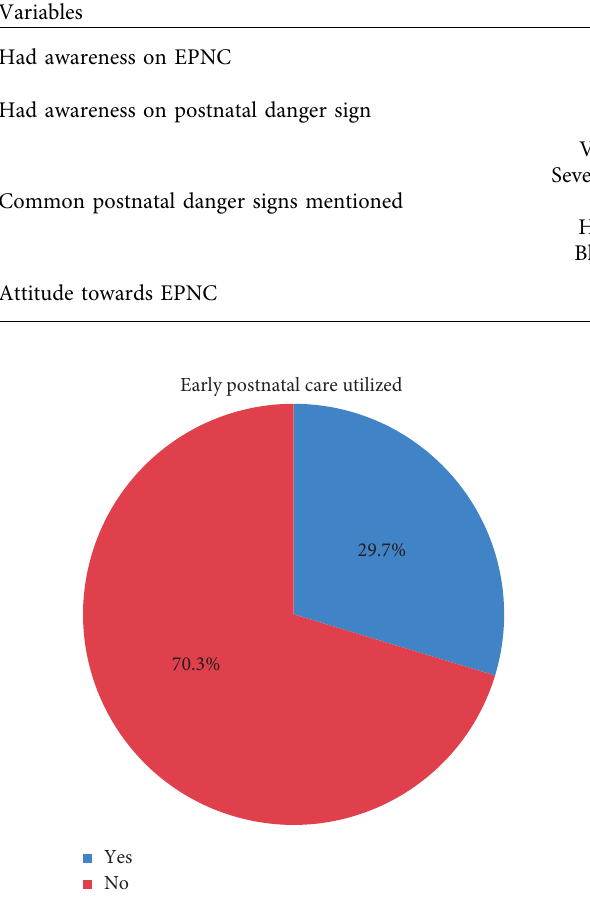
Figure 1: Magnitude of early postnatal-care services utilized by the respondents in Hawassa Zuria District, Sidama Regional State, Ethiopia, 2020.